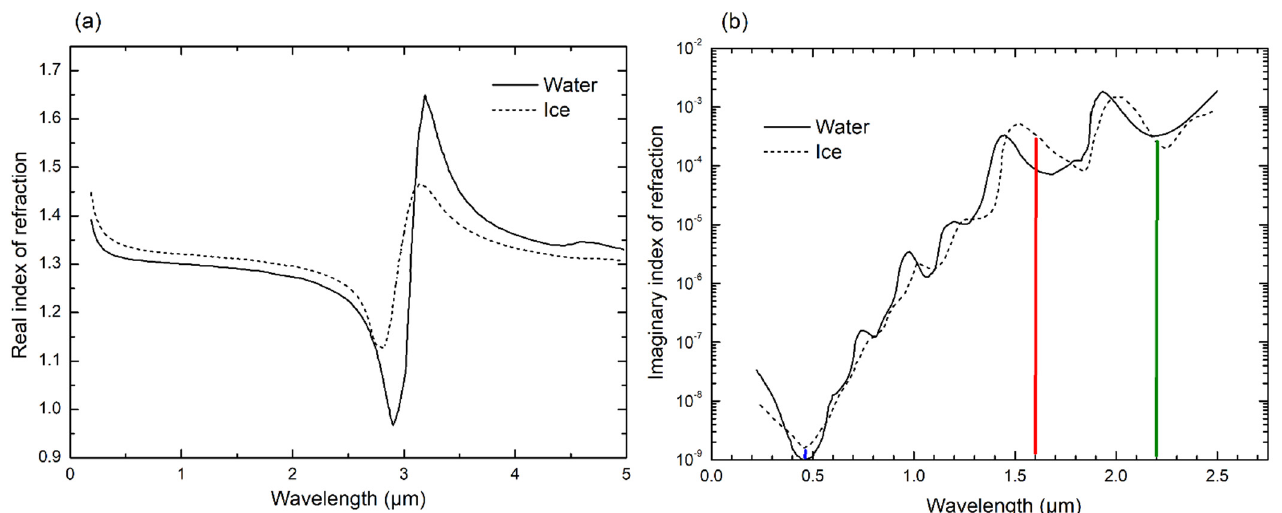
Figure 1. Real ( a ) and imaginary ( b ) index of refraction for water and ice with wavelengths (( a ): reproduced from Kokhanovsky [31], ( b ): reproduced from Warren [32]); the vertical blue, red, and green lines correspond to absorption at 0.46, 1.6, and 2.2 µm, respectively.